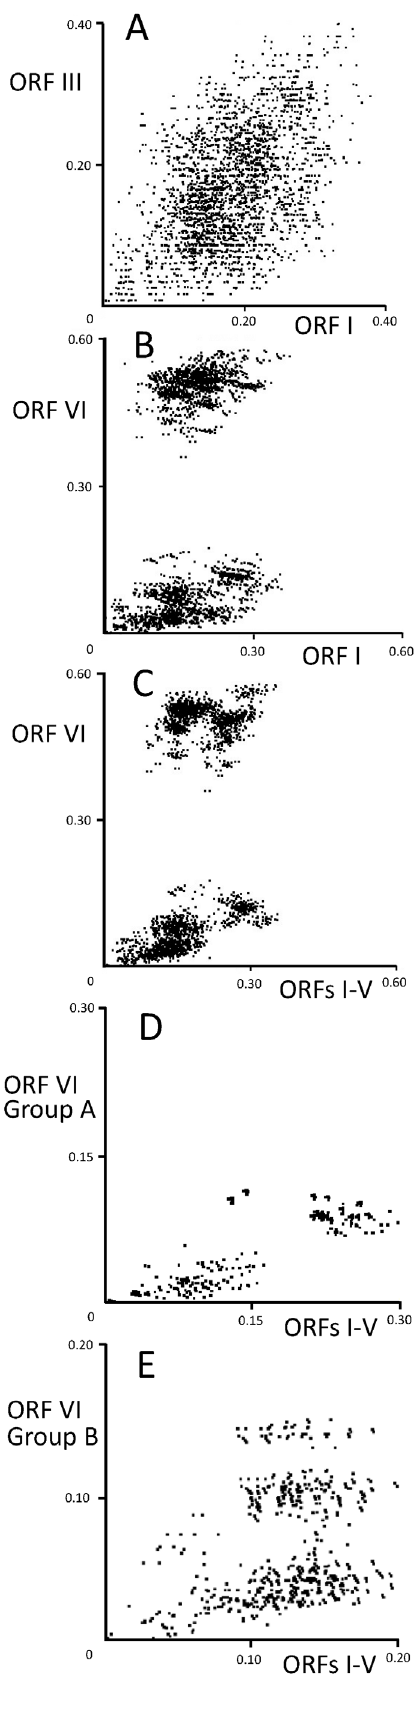
Figure 1. Multidimensional scaling of tree-to-tree patristic distances. ORF I vs ORF III isolates (A); ORF I vs ORF VI isolates (B); ORFs I–V vs ORF VI isolates (C); ORFs I–V Group A vs ORF VI isolates (D); and ORFs I–V Group B vs ORF VI isolates